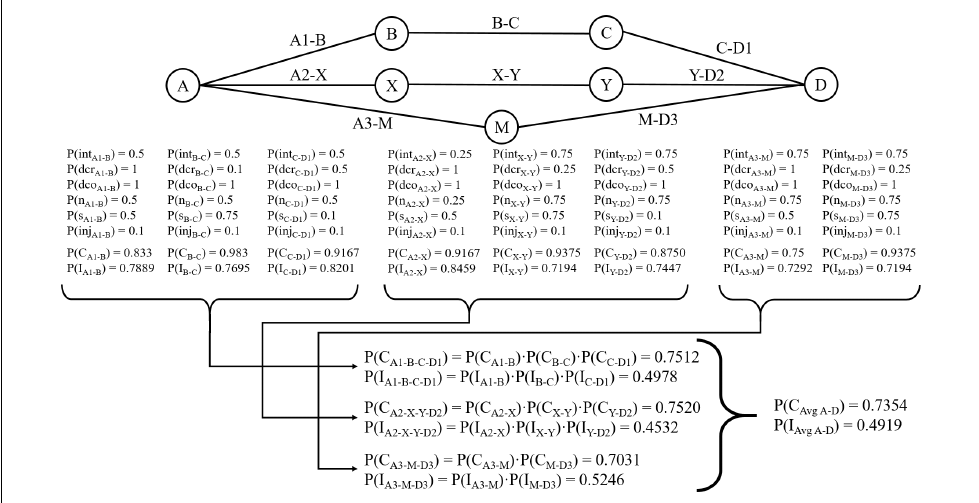
Figure 8. A Three-Channel, Three-Hop Network with QoSS Characteristics and Equivalent Network